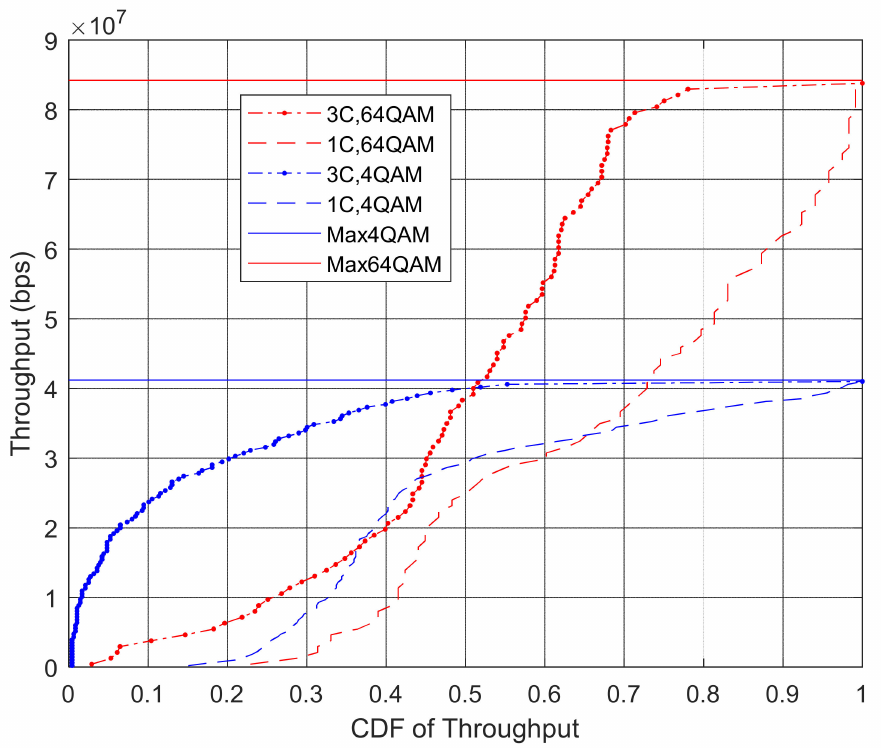
Figure 8. Throughput performance (bps) vs. CDF of throughput for UMa scenario with N tx = 5 N u , N f = 4, N af = 3, N s = 5, N a = 2, N rx = 5, 64QAM (11.75 bpcu per user) and 4QAM (5.75 bpcu per